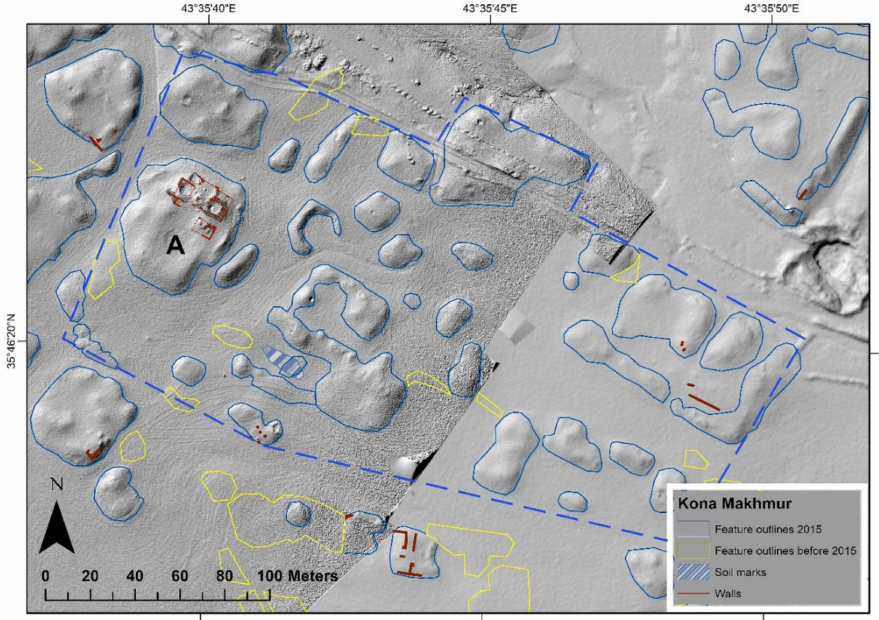
Figure 8. Kona Makhm¯ur, general interpretation of part of the site: Combination of image-based digitalization of features with the results of field verification (walls) (authors: Karel Nov á ˇcek, Lenka Starkov á